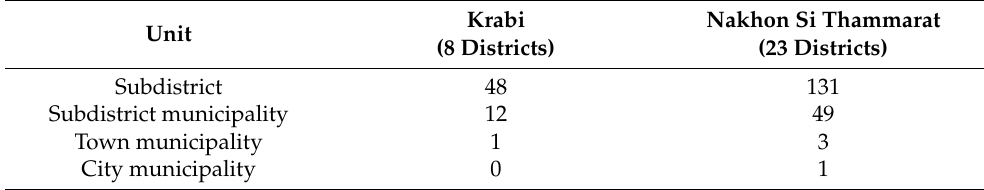
Figure 1. Map of study area. Table 1. Number of administrative units by province.